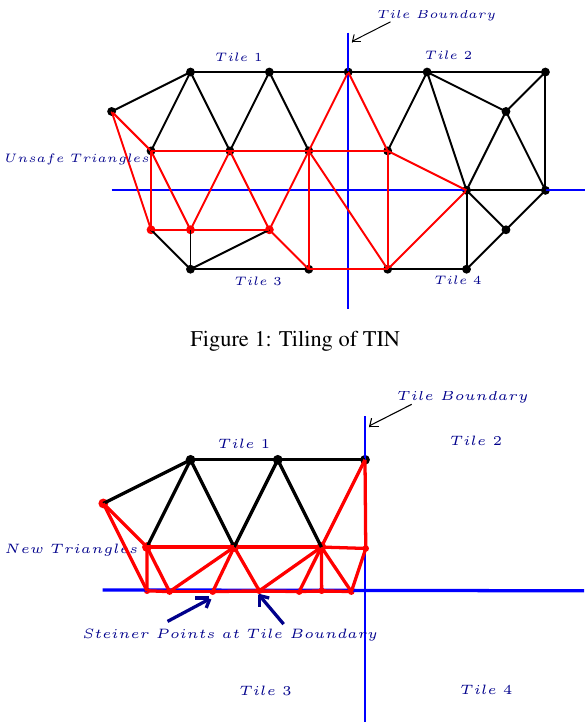
Figure 2: Addition of Steiner Points